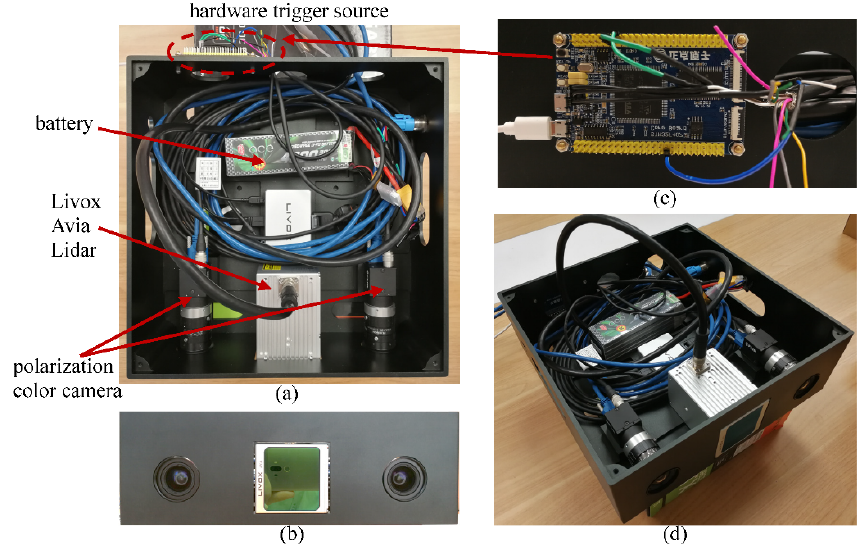
Figure 2. The hardware configuration: ( a ) experimental platform equipped with the polarization color stereo camera and the Livox Avia LiDAR. The LiDAR system is powered by a LiPo battery, commonly used in the quadcopter helicopter; ( b ) the front view of the hardware system; ( c ) the hardware trigger source, which is achieved using a STM32F407 development board. It realizes the synchronization of the cameras and the LiDAR based on the PPS synchronization methods; ( d ) the general view of the hardware system.